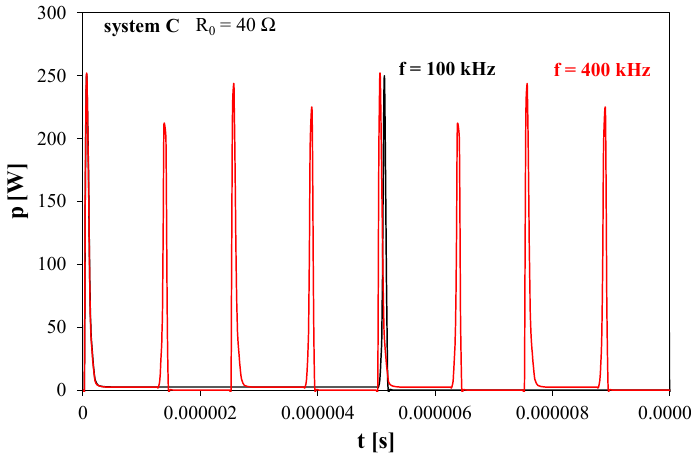
Figure 8. Waveforms of the power dissipated at the steady state in the transistor operating in the switch circuit and cooperating with the cooling system C at selected frequency values.